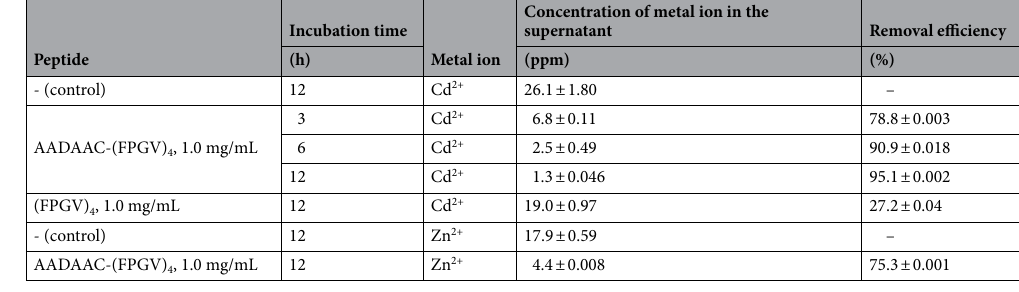
Table 3. The removal efficiency of metal ions with the AADAAC-(FPGV) 4 treatment. Mean removal efficiency with SE were shown in the table. Each peptide was dissolved in Tris–HCl buffer solution (50.0 mM Tris, 599 mM NaCl, pH 8.0). The measurements were repeated at least three times. The molar concentration ratio of